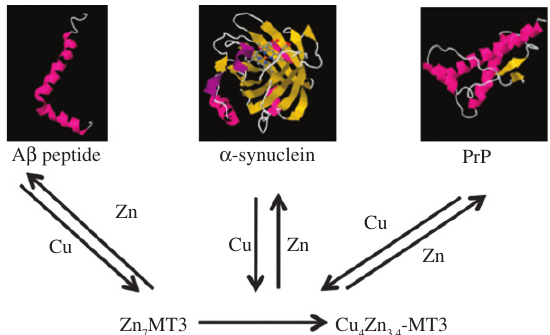
Figure 4 Metal swap reactions leading to Cu(II)/Zn(II) exchange between the Cu(II)-loaded forms of the A β peptide (1IYT entry in PDB), α -synuclein (1X8Q entry in PDB), and the bovine PrP (1DX0 entry in PDB), whose aggregation is responsible of the AD, PD, and spongiform encephalopathy neurodegenerative disorders, respec- tively. All protein structures have been represented using Jmol, an open source Java viewer available at